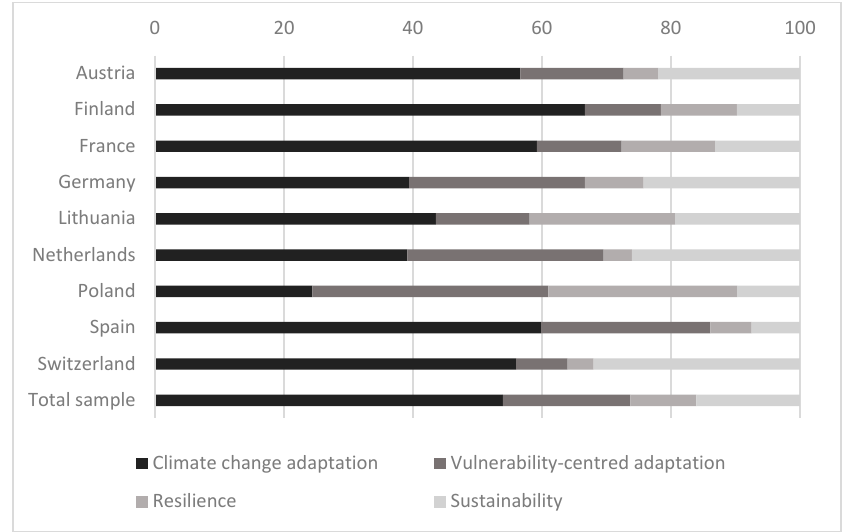
Figure 1. Adaptation policy instruments grouped by policy aims (%).